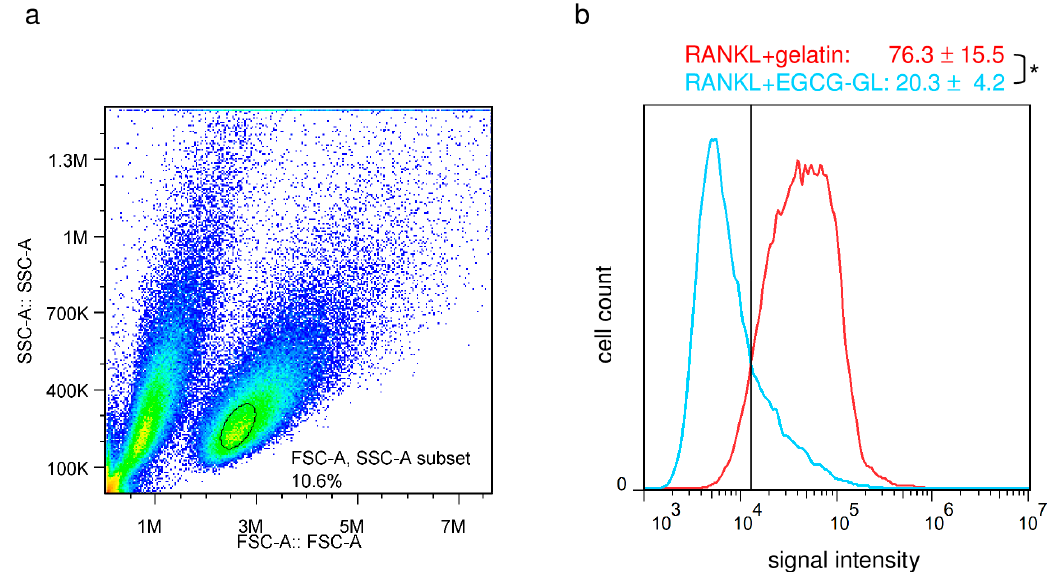
Figure 4. EGCG-GL attenuates the receptor activator of nuclear factor-kB ligand (RANKL)-mediated intracellular reactive oxygen species (ROS) levels. ( a ) The viable cellular fraction of monocytes/macrophages was gated on a forward scatter/side scatter plot (black circle). ( b ) Intracellular ROS levels in RANKL-treated (red) and RANKL- and EGCG-GL-treated RAW 264.7 cells (blue). The vertical line indicates a conventional threshold for ROS-negative and -positive populations. Mean percent of ROS-positive cells are shown on top. (n = 3) *: p < 0.05 between samples.